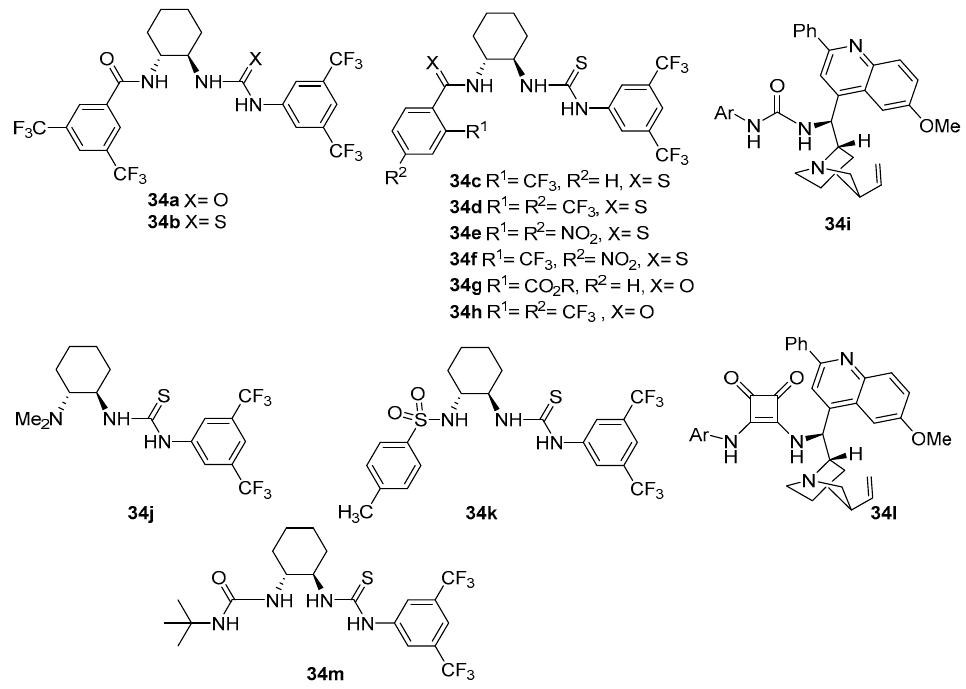
Figure 1. Chiral ureas and thioureas used as catalysts for the CCR.